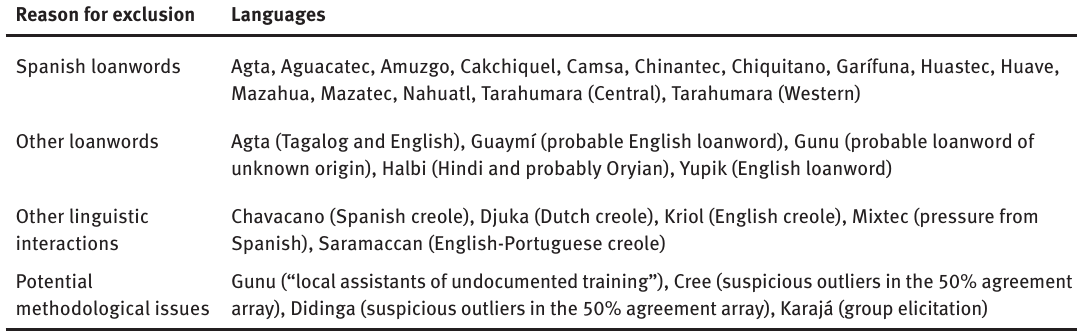
Table 1: Excluded languages. Reason for exclusion